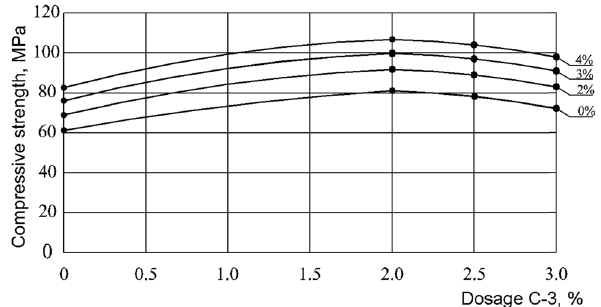
Figure 9: Compressive strength of a 3 days old plasticized, dis - persed fi ber - reinforced cement mixture.